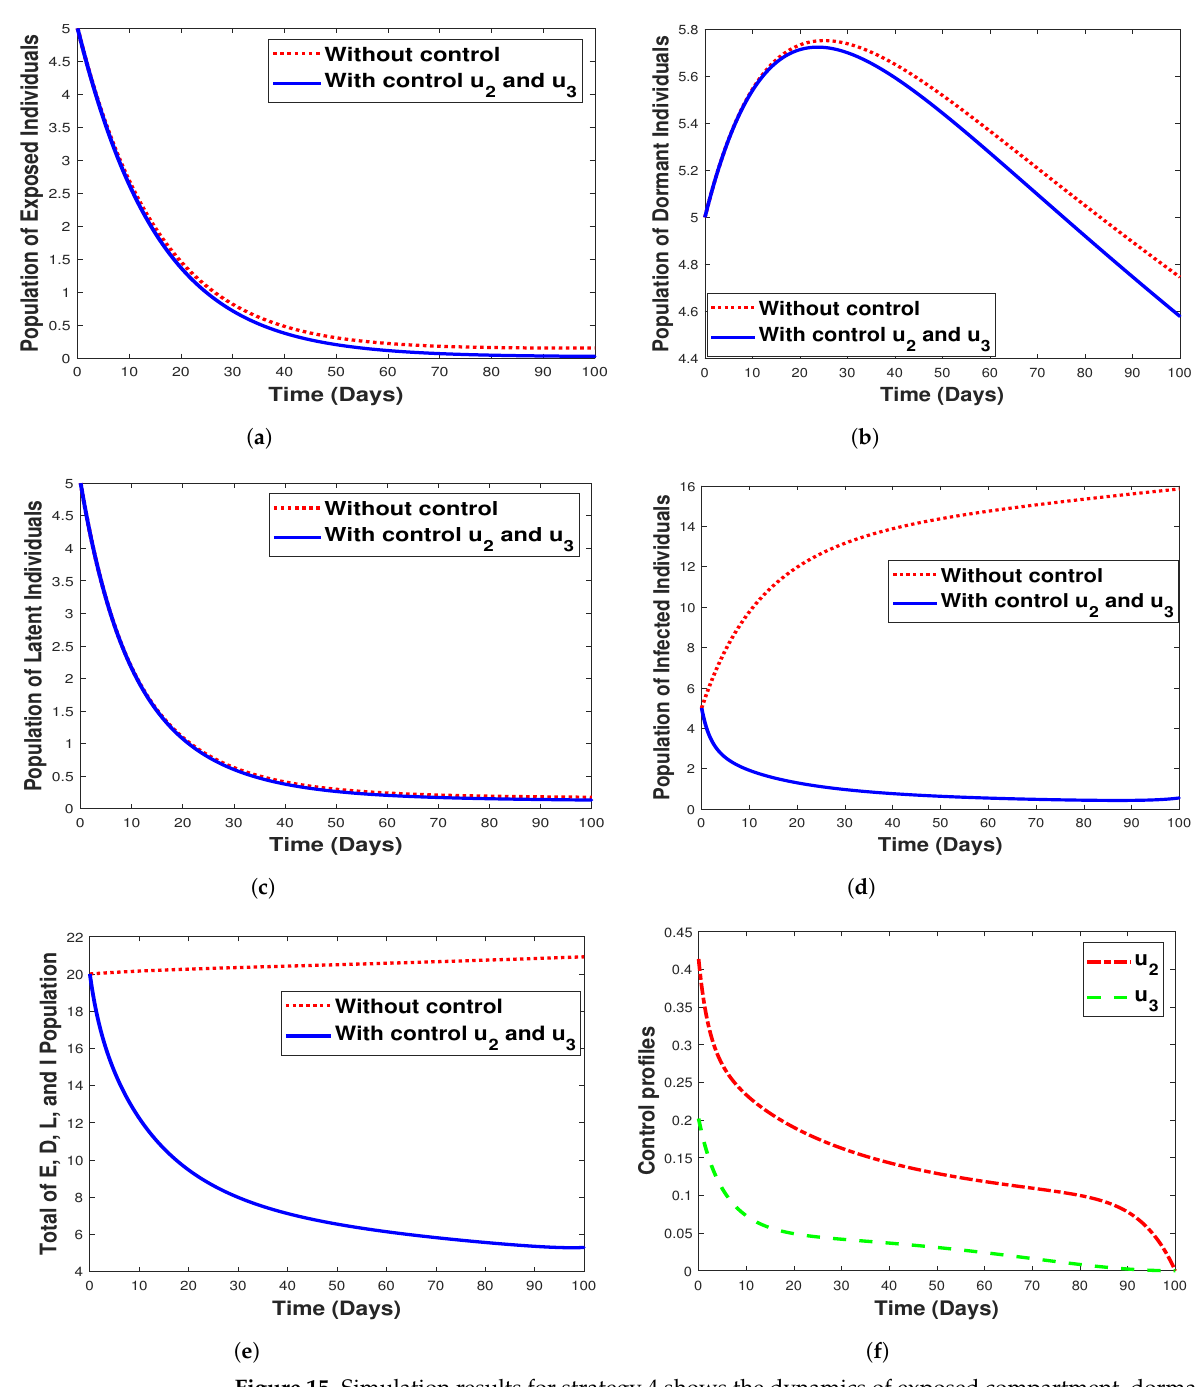
Figure 15. Simulation results for strategy 4 shows the dynamics of exposed compartment, dormant compartment, latent compartment, infected compartment, total of exposed, dormant, latent, and infected population, and the dynamic of control u 1 and u 2 for subfigure ( a )–( f ),